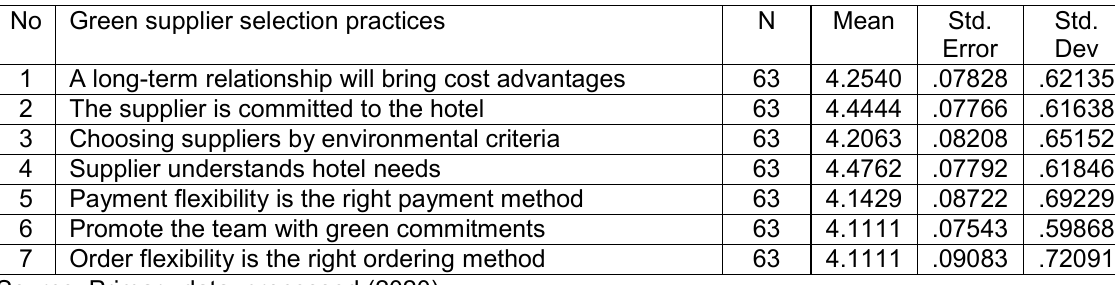
Table 1. Descriptive Analysis of Green Supplier Selection Practices